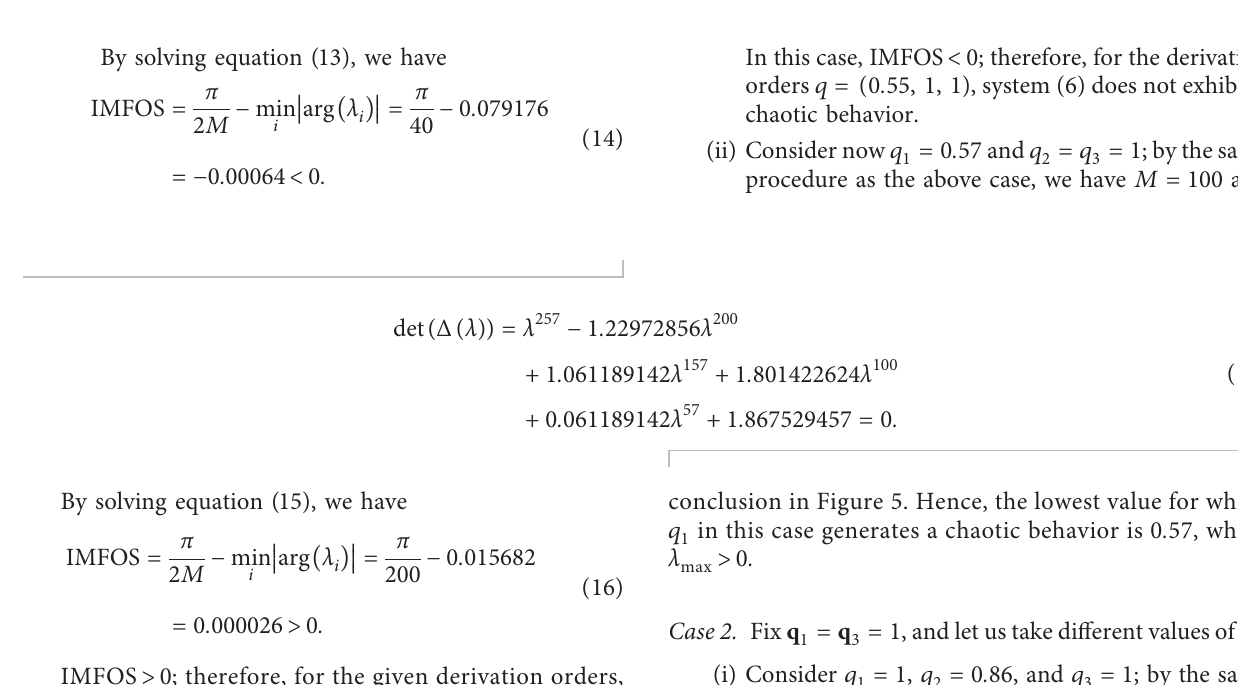
� q � 1, and (c) q 1 3